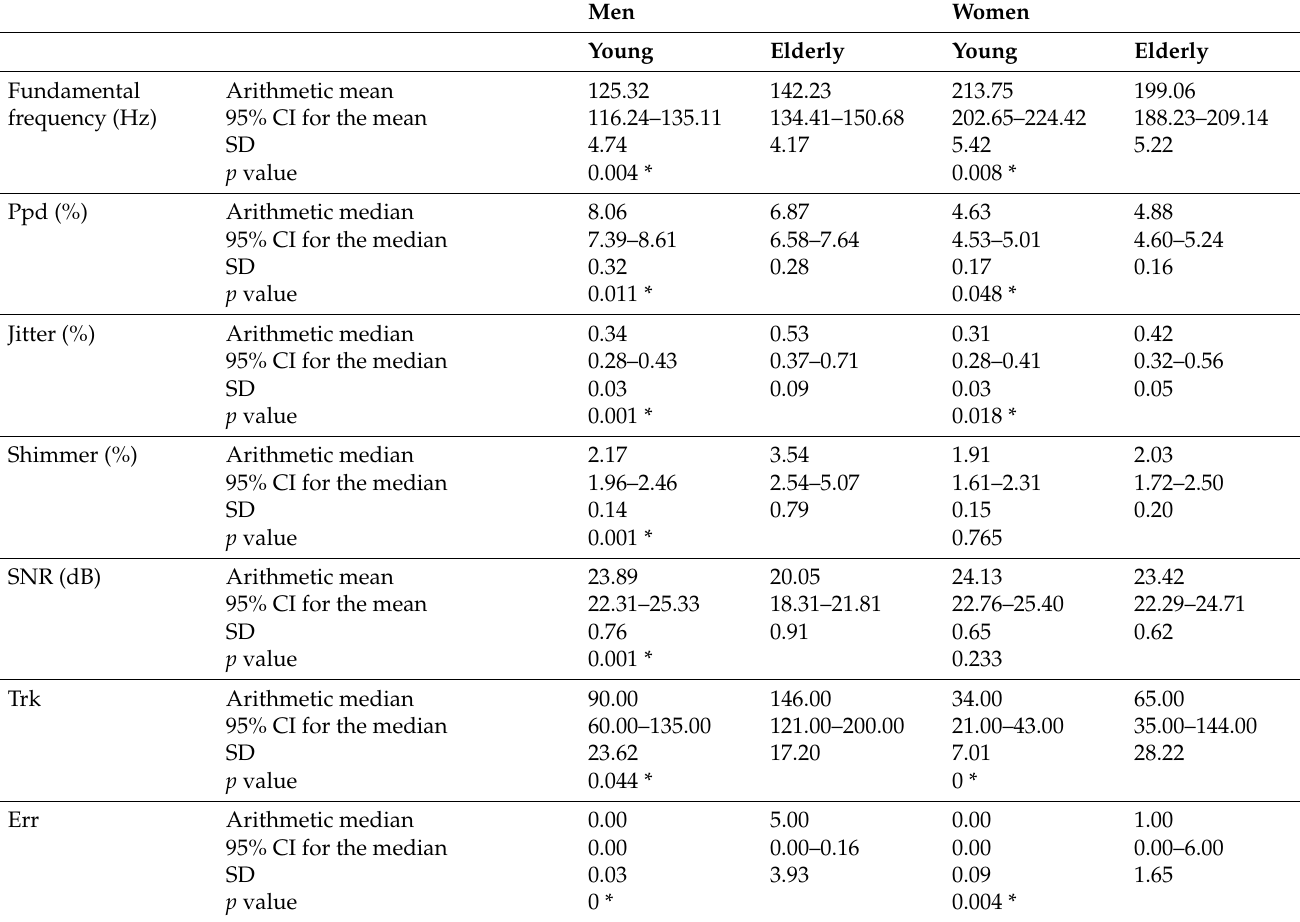
Table 2. Means, 95% CIs for the mean and median, and SDs for all parameters analyzed with TF32. Men Women Young Elderly Young Elderly 125.32 142.23